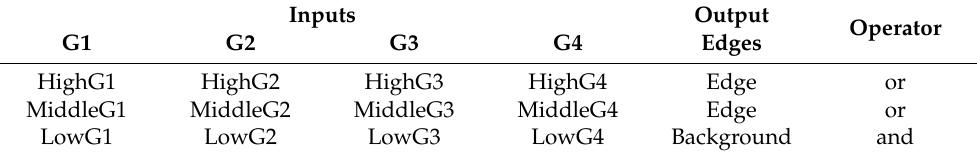
Table 2. Fuzzy rules base for fuzzy MG